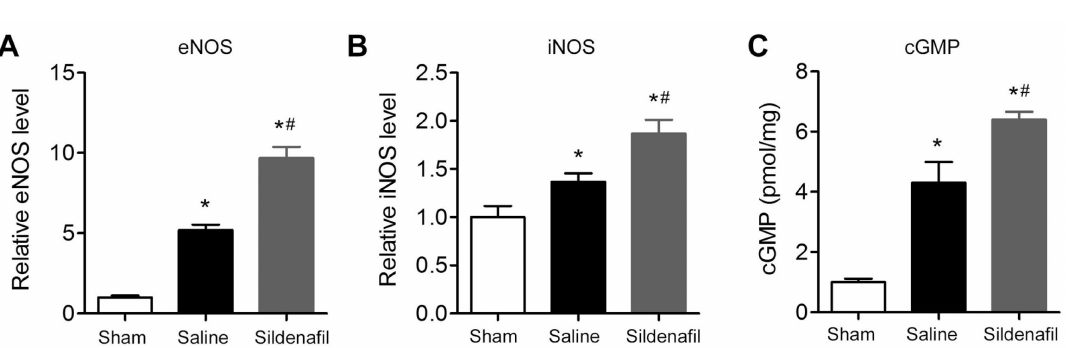
Figure 8. Effect of sildenafil on the levels of endothelial nitric oxide synthase (eNOS), inducible nitric oxide synthase (iNOS), and cyclic guanosine monophosphate (cGMP) in myocardial tissue after post-resuscitation in a porcine myocardial I/R injury model. ( A ) Relative eNOS levels; ( B ) relative iNOS levels; and ( C ) relative cGMP levels in myocardial tissue from sham, saline, and sildenafil-treated groups. A total of 20 µ g of cardiac protein homogenate was used to measure the levels of eNOS, iNOS, and cGMP by ELISA. The levels of eNOS, iNOS, and cGMP in the Sham group were set as 1 and the relative fold increase in tissue of the saline and sildenafil group was calculated, respectively. * p < 0.05 vs . Sham; # p < 0.05 vs . Saline. n = 6–10 per